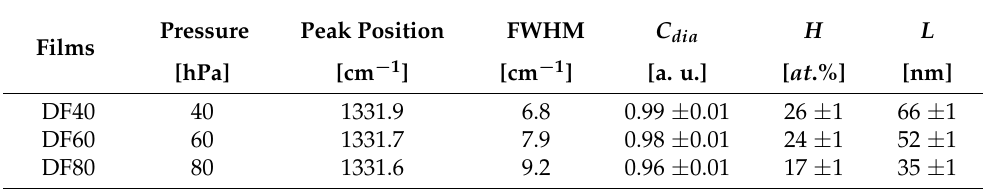
Table 1. The structural properties of diamond films derived from Raman spectra and XRD.